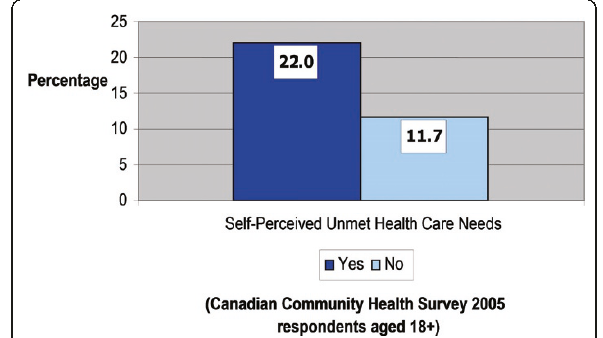
Figure 2 Percentage of population consulting an alternative health care provider with self-perceived unmet health care needs